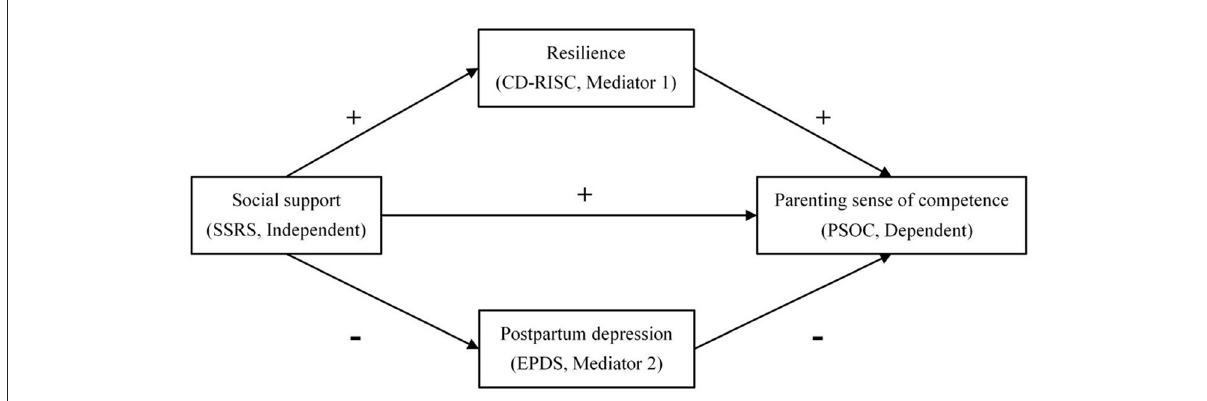
FIGURE1 Conceptual framework of the social support, resilience, postpartum depression and parenting sense of competence among puerperal